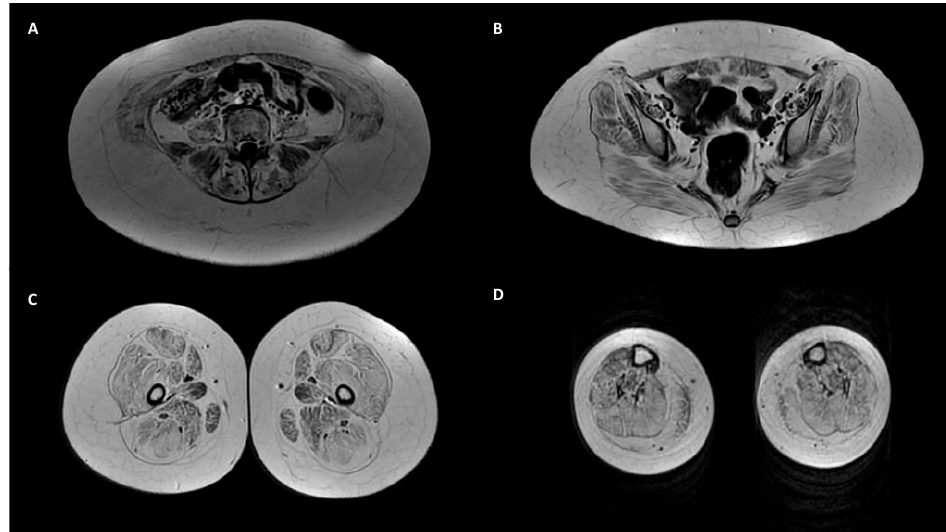
Figure 3. Axial T1 SE imaging of patient ID 1 that shows: marked and widespread fibro-adipose substitution of muscles (grading 3/4 according to “Mercuri score”) at the level of the pelvis ( A , B ); wide and marked involvement with a latero-mesial gravity gradient of thighs ( C ); wide and marked involvement of leg muscles ( D ).